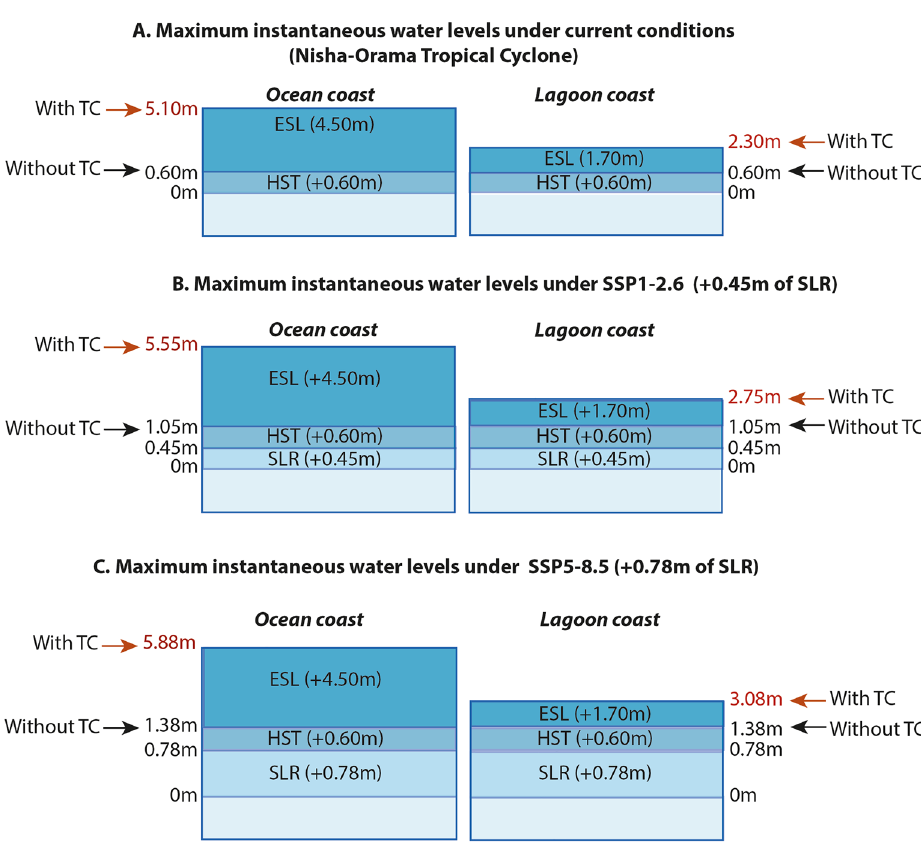
Figure 7. Maximum instantaneous water levels under current and future conditions on Avatoru Island, Rangiroa Atoll. Maximum instantaneous water levels are shown for a Nisha-Orama type Tropical Cyclone (the most extreme Tropical Cyclone observed on Rangiroa, in 1983). Future conditions correspond to SSP1-2.6 and SSP5-8.5 climate scenarios in 2100. HST, High Spring Tide; ESL, Extreme Sea Level associated with a Nisha- Orama-type Tropical